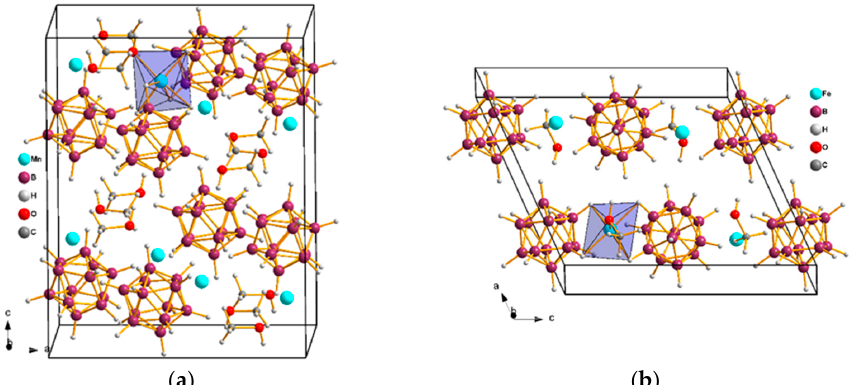
Figure 11. ( a ) View of the Mn coordination octahedron M(MeOH)H 5 bridging two closo -borate anions in o -Mn(MeOH)(B 12 H 12 ), and forming zig-zag chains along the b -axis. The closo -borate anions are packed in pseudo-hexagonal layers perpendicular to b -axis and forming nearly regular hcp . ( b ) View of the Fe coordination square pyramid M(MeOH)H 4 in m -Fe(MeOH)(B 12 H 12 ) forming straight chains along the c -axis. The closo -borate packing deviates strongly from hcp . Both structures as optimized by DFT.